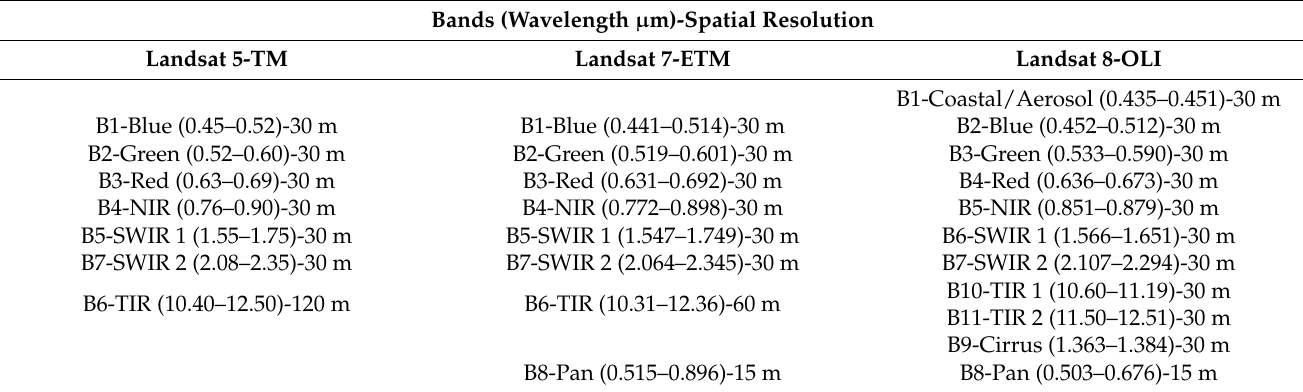
Table 2. Spectral and Spatial characteristics of the Landsat images used in this study.